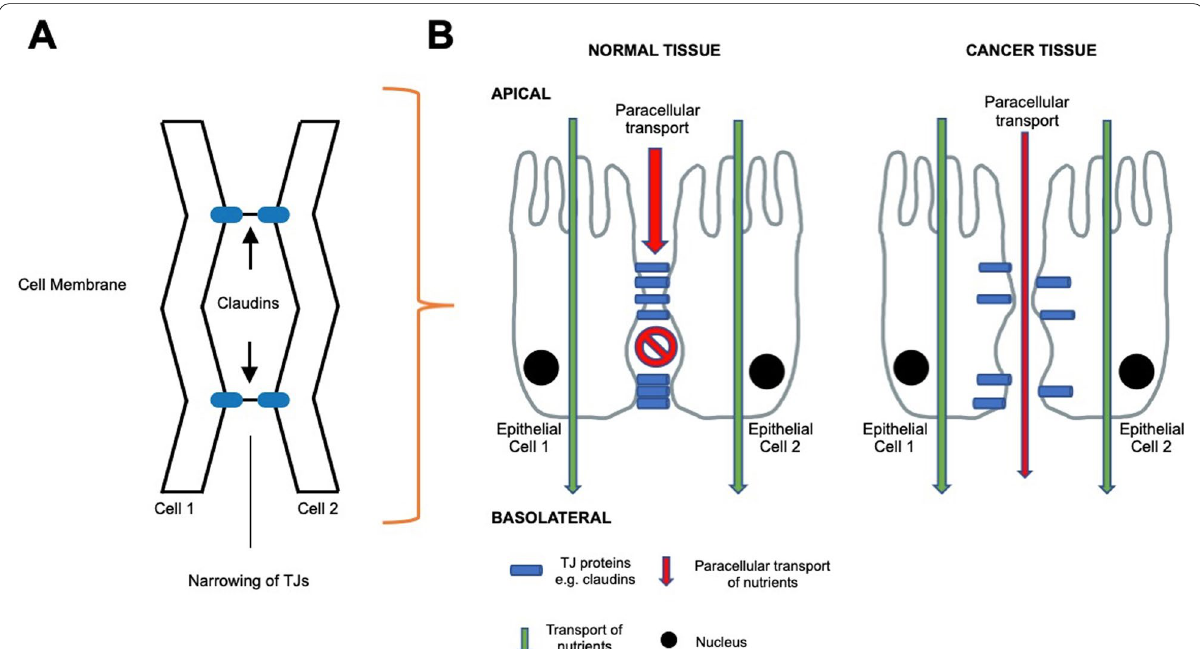
Fig. 1 A Schematic view of the claudins in the TJ. The claudins are located at the membranes, narrowing the TJs, thereby increasing barrier function. B Epithelial cell‑to‑cell contact, where claudins are located at the membranes. In non‑tumorigenic tissues, the TJ is intact between the cells, meaning there is controlled paracellular transport of nutrients and growth factors. When there is a loss of TJ activity, such as that seen in tumorigenesis, the barrier weakens, allowing for more liberal paracellular transport of nutrients and growth factors [6, 7,